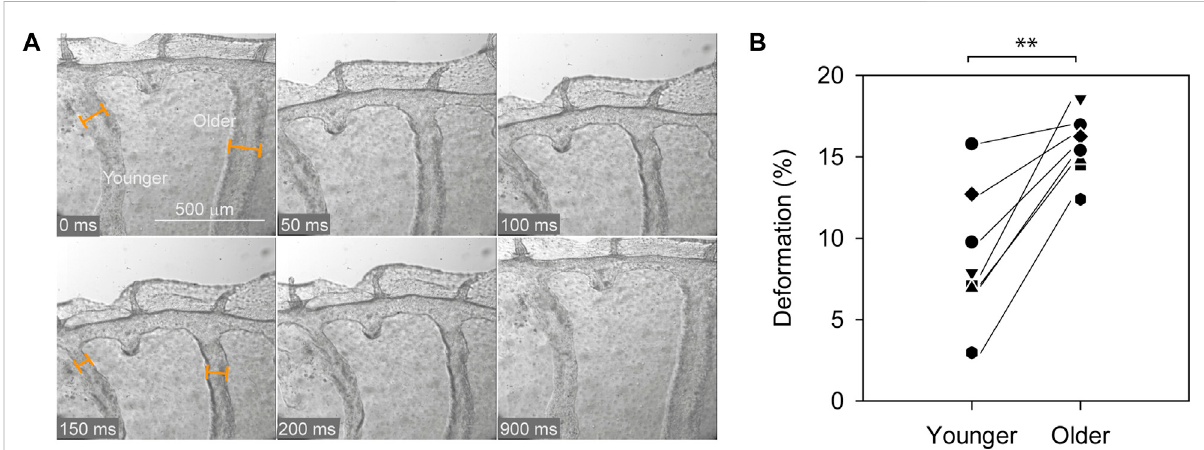
FIGURE 3 Relative contraction of canals during jelly fi sh swimming contraction. (A) A sequence of pictures showing a young and an older canal pictured during a contraction (with also a canal sprout in between). Canal width measurement during the resting phase and the maximum contraction allows measuring the relative contraction of the canals. (B) The pairwise measurement shows that the contraction of a young canal is signi fi cantly smaller than the one for older canals ( p < 0.01, one-way repeated measures Anova, followed by a Student – Newman – Keuls test for a pairwise multiple